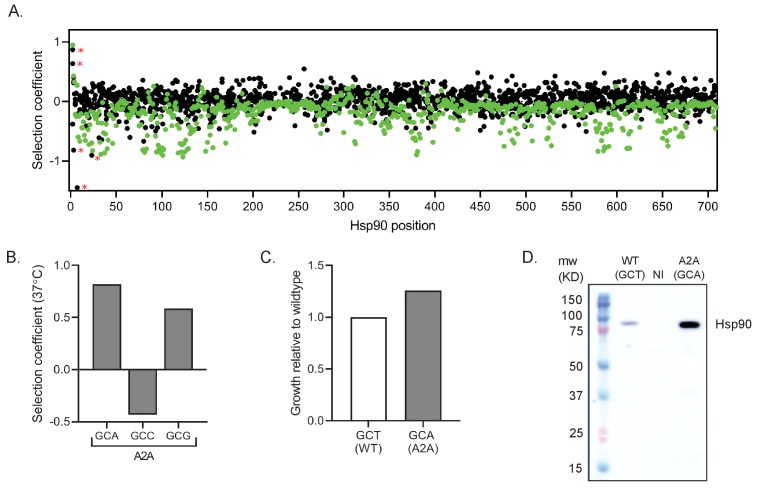
Synonymous mutations at the beginning of Hsp90 have strong beneficial growth effects.(A) Selection coefficients for all codon variants of synonymous mutations at each position of Hsp90 (black) at 37°C compared to the average selection coefficient of all mutations at each position (green) at 37°C. Synonymous mutations that were deemed beneficial or deleterious after a Bonferroni correction are noted with a red asterisk. (B) Selection coefficients for codon variants of synonymous mutants at position Ala2 show high variation. (C) The individual Hsp90 variant containing the synonymous codon mutation GCT to GCA at position 2 exhibited an increased growth rate 37°C. (D) The individual synonymous mutant variant GCA at position two exhibited higher cellular expression levels at 37°C. WT: wild-type Hsp90 (GCT at 2nd position), NI: No insert, A2A: Hsp90 with the GCT to GCA codon mutation.